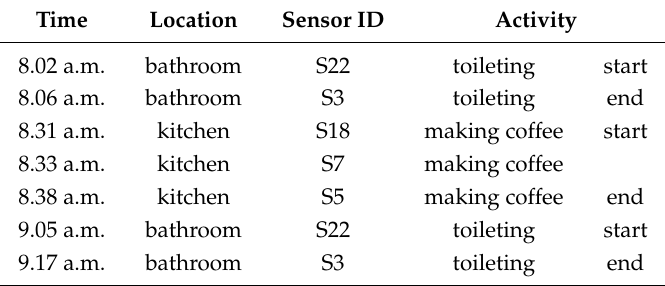
Table 1. An example of user-interaction events in a smart home.